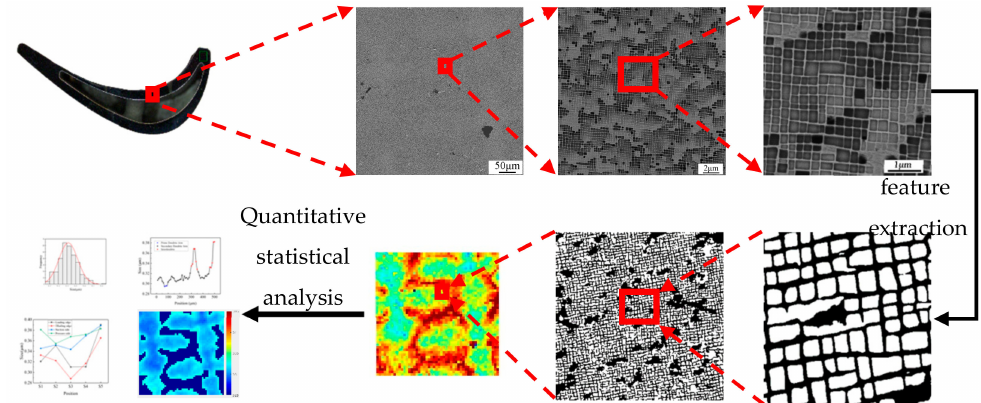
Figure 4. The SEM image collection, identification extraction and quantitative statistical analysis process of γ ’ phase in single crystal